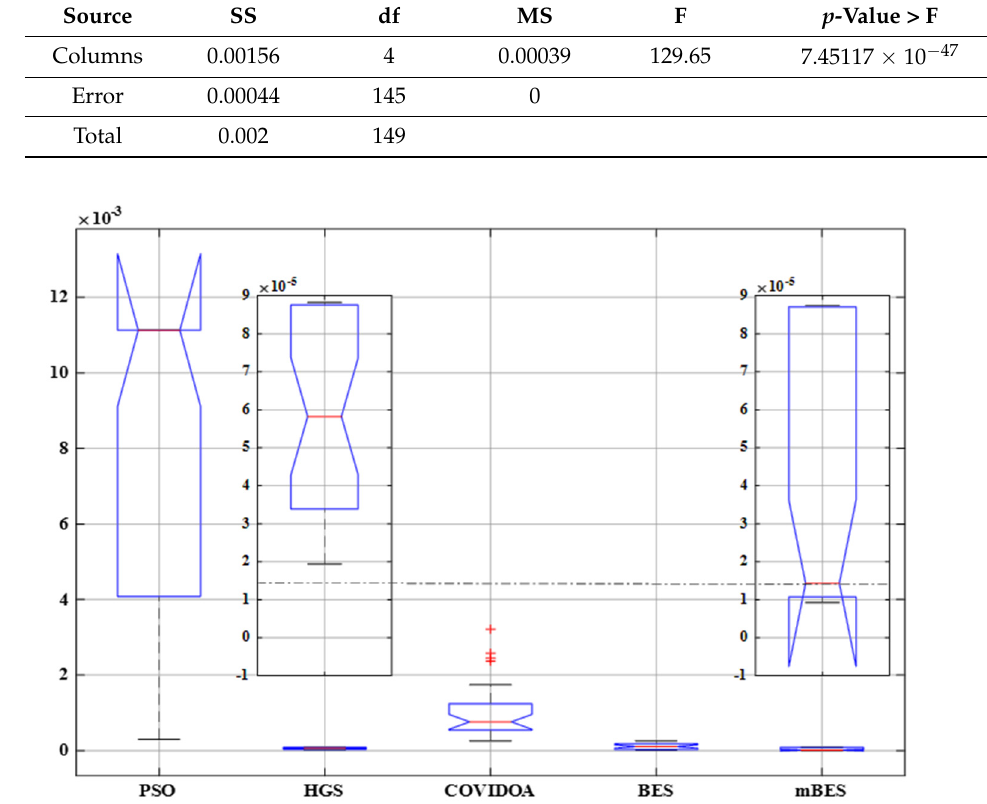
Figure 6. ANOVA ranking for control.